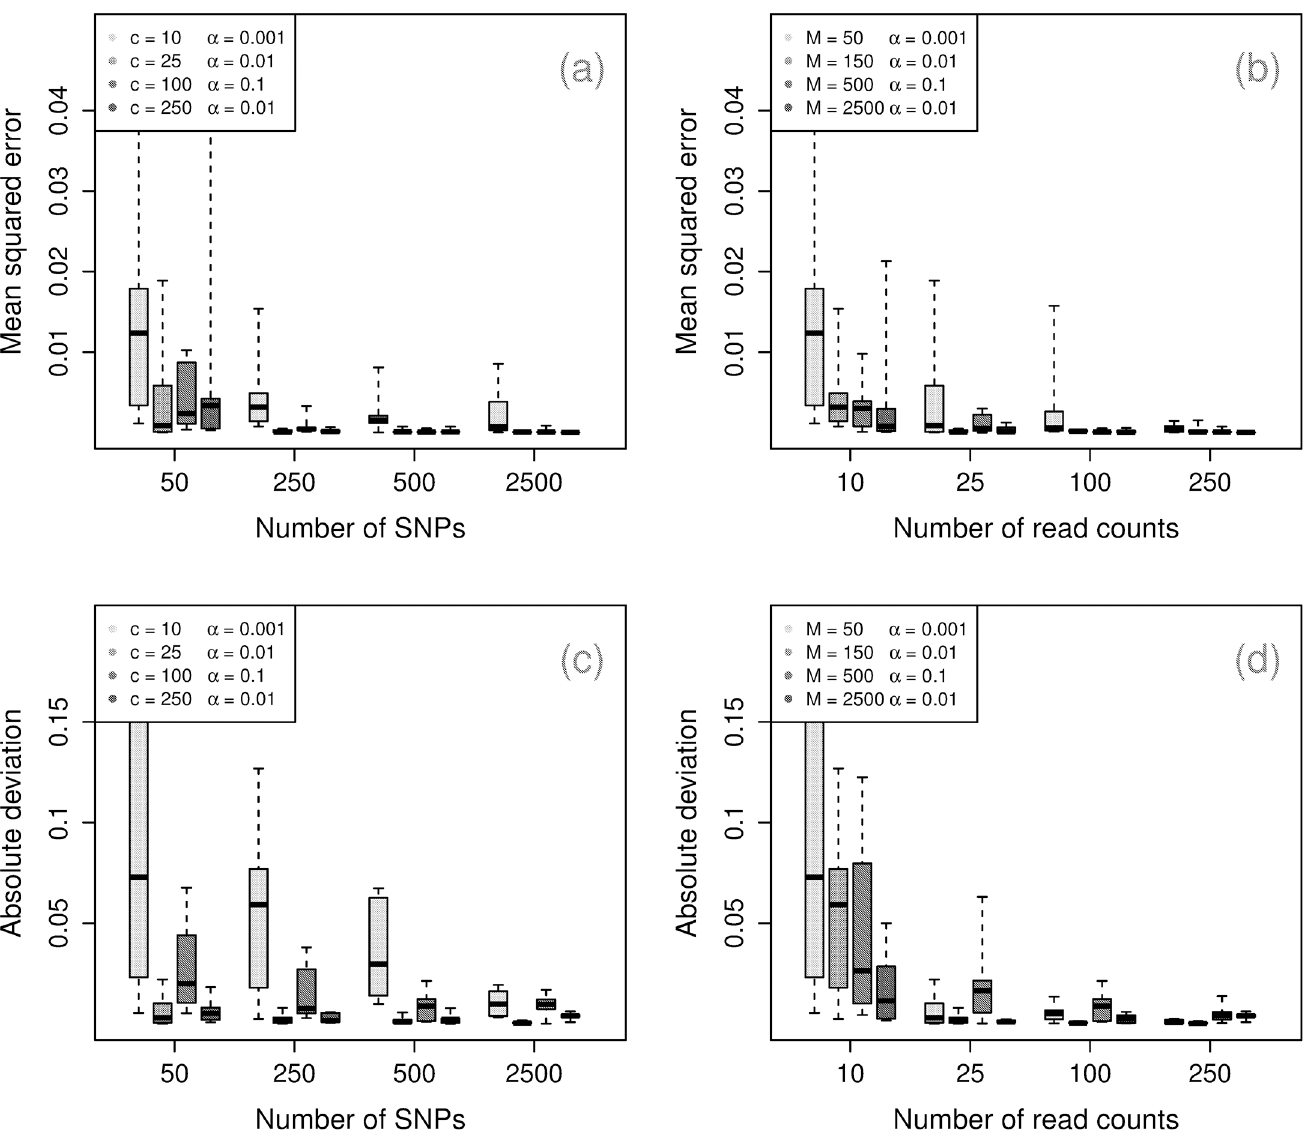
Fig 4. Performance for parameter inference. Upper row: mean squared deviation for strain frequencies by number of read counts (left) and by number of SNPs (right). Lower row: absolute normalized deviation for panmixia coefficient by number of read counts (left) and by number of SNPs.